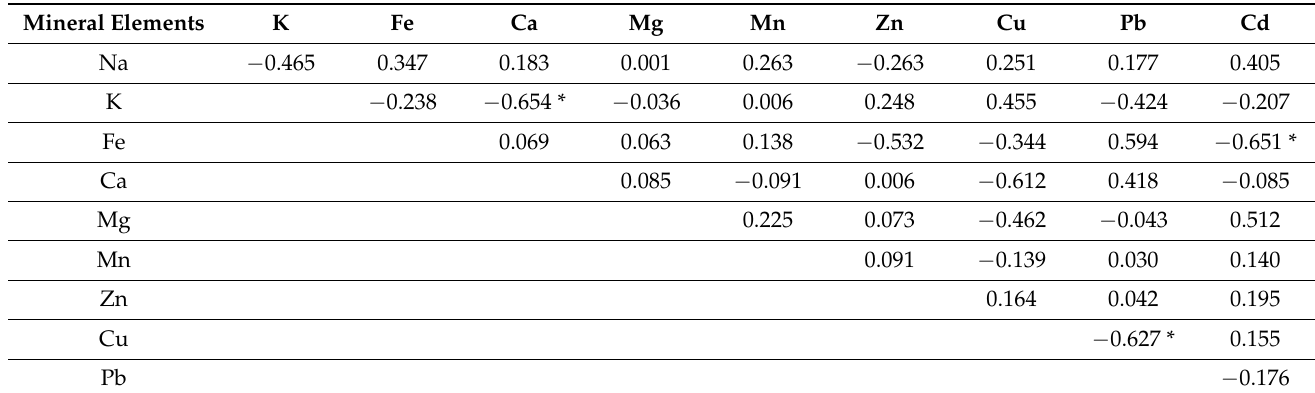
Table 7. Correlation coefficients (r xy ) for the levels of selected mineral elements and toxic metals in the liver of red deer.